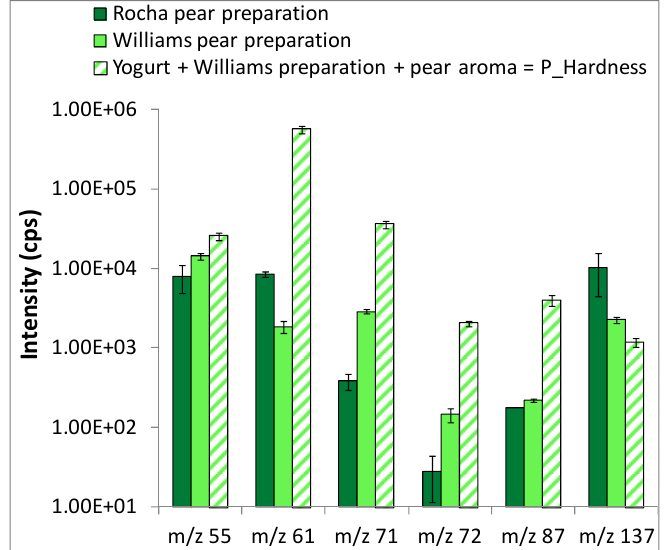
Figure 2. Mean and standard deviation of the intensity of fragments selected for in vivo analysis (logarithmic scale). Data were obtained from in vitro PTR-MS measurements individually performed in the headspace above pear preparations and above P_Hardness yogurt. The PTR-MS instrument drift tube was thermally controlled (60 °C) and